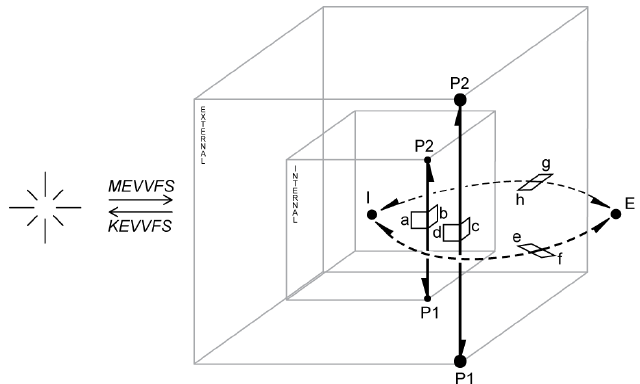
Figure 11. MEVVFS/KEVVFS Euler operator.